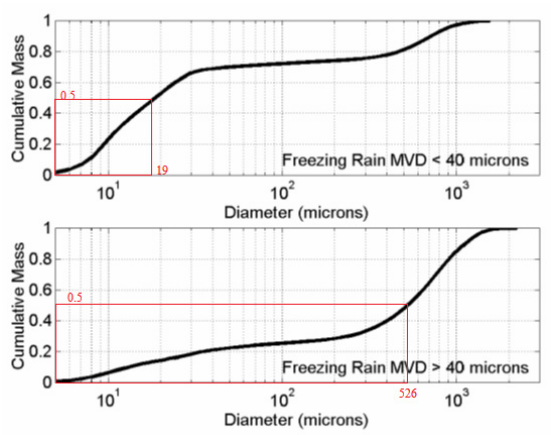
Figure 7. Appendix O—freezing rain, drop diameter distribution.